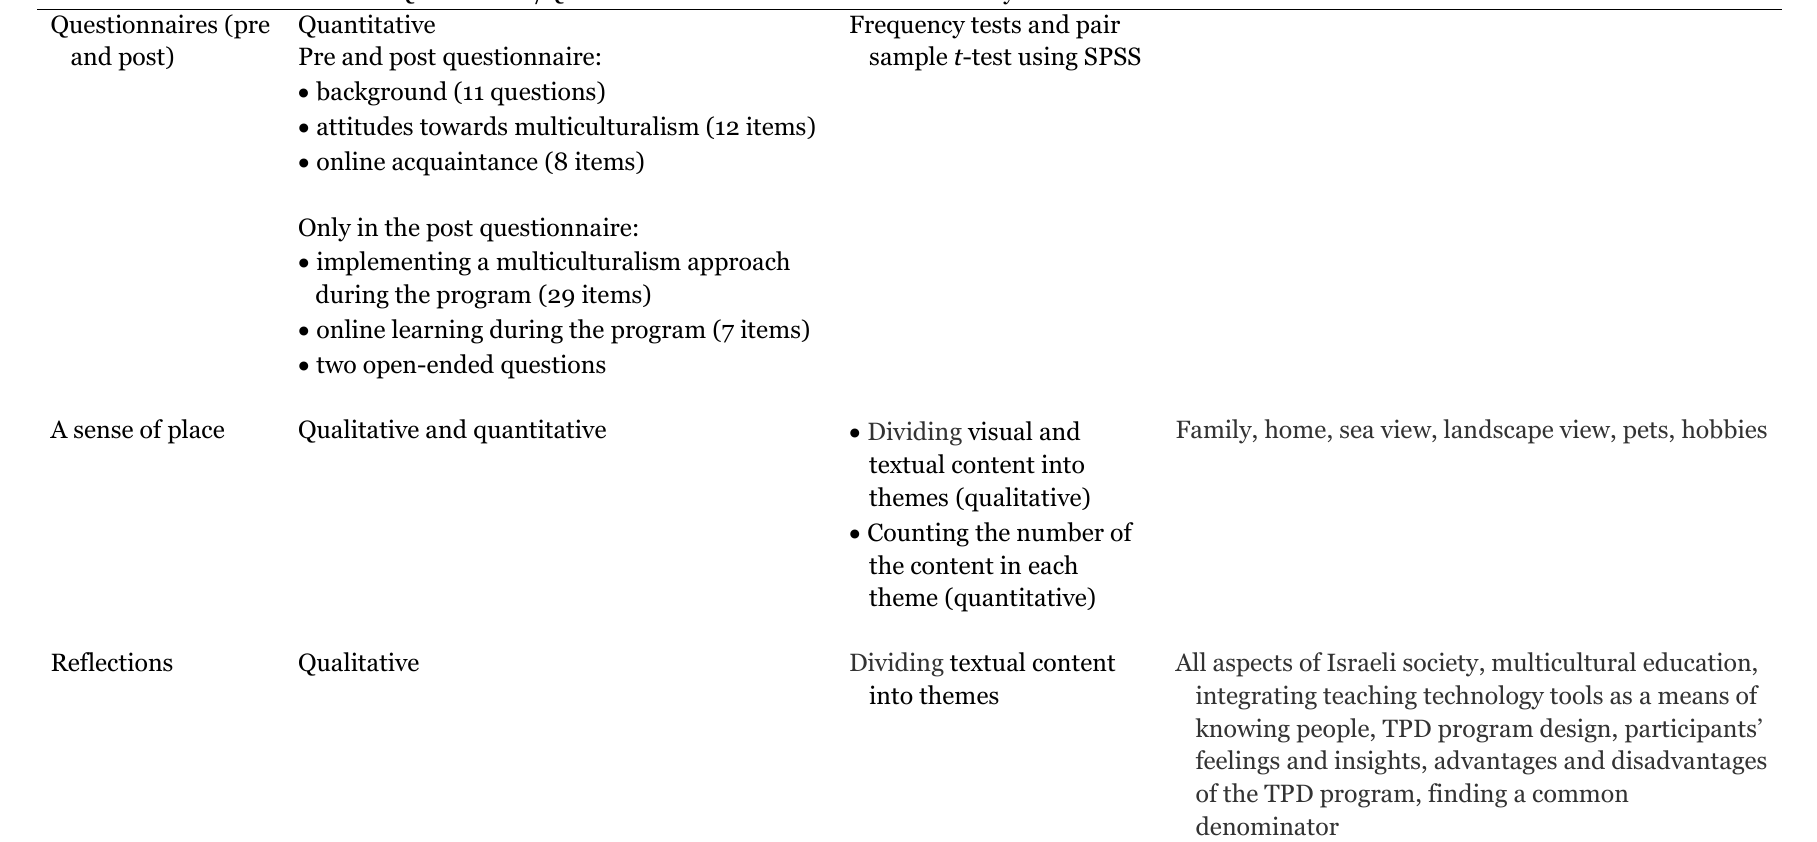
Table 2 Data Collection Tools, Quantitative or Qualitative Data, Data Analysis, and Themes Data collection